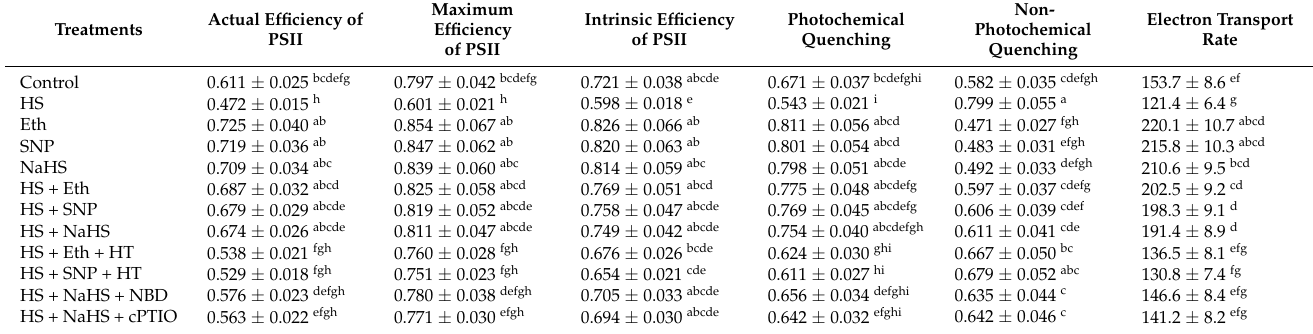
Table 3. Actual efficiency of PSII, maximal efficiency of PSII, intrinsic efficiency of PSII, photochemical quenching, non-photochemical quenching, and electron transport rate of rice ( Oryza sativa L.) cultivar Rasi after foliar treatment of plants with 200 µ L L − 1 ethephon (Eth), 100 µ M sodium nitroprusside (SNP), or 200 µ M sodium hydrosulfide (NaHS) grown with or without high temperature stress (HS; 40 ◦ C) or 100 µ M hypotaurine (HT), 100 µ M 2-4-carboxyphenyl-4,4,5,5 -tetramethylimidazoline-1- oxyl-3-oxide (cPTIO) or 100 µ M norbornadiene (NBD) scavengers of hydrogen sulfide (H 2 S), nitric oxide (NO), and ethylene action inhibitors, respectively, with HS at 15 days after sowing. Data are presented as treatments mean ± SE ( n = 4). The values followed by the same letters did not differ significantly by LSD test at p <